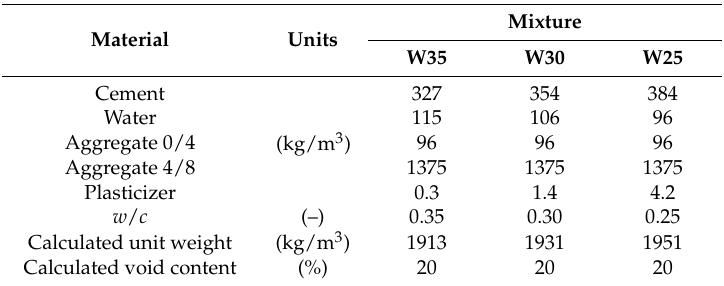
Table 2. Proportions of pervious concrete mixtures per 1 m 3